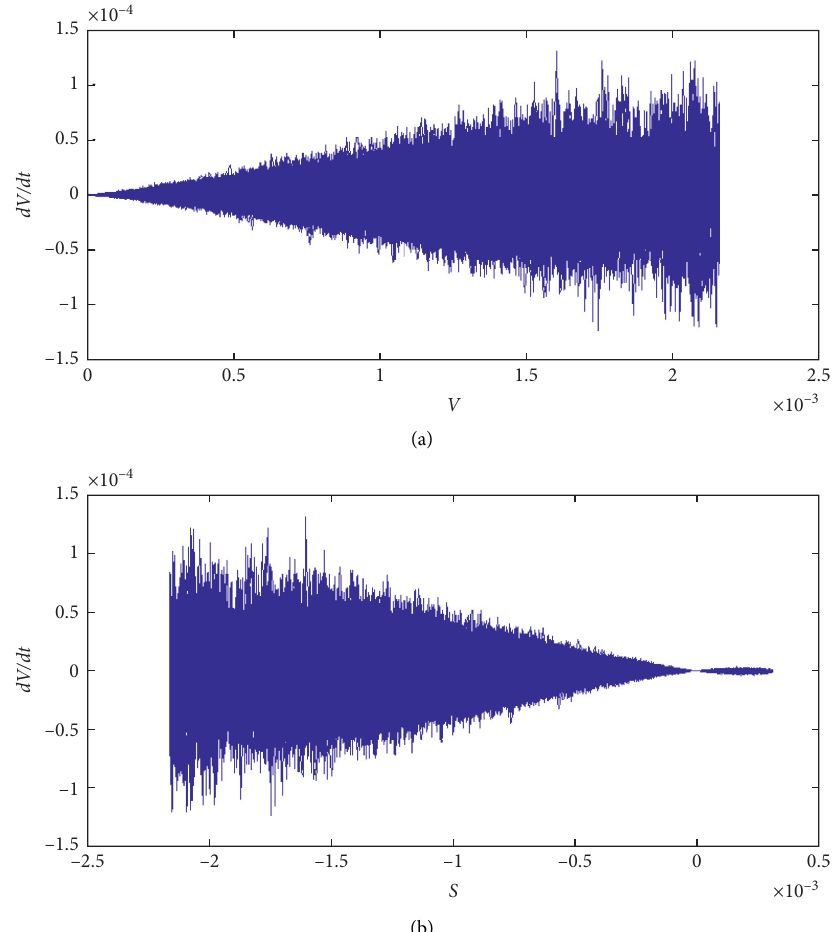
Figure 21: d V /d t versus V and s for the controlled system with σ � 0 . 005. (a) d V /d t versus V and (b) d V /d t versus s